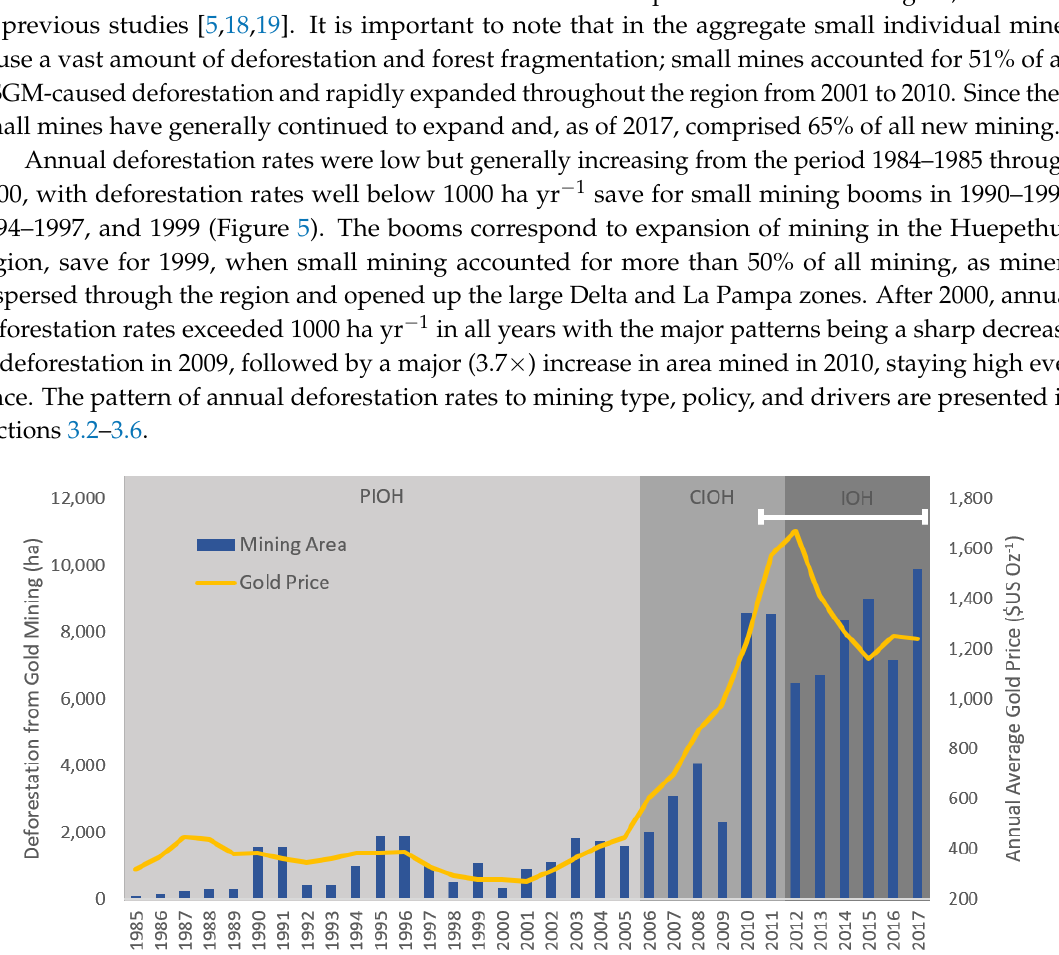
Figure 5. Annual rate of deforestation over 34 years due to ASGM in the Southeastern Peruvian Amazon. Particularly notable is the sharp increase in mining in 2010, which correlates well with gold price, followed by consistently high levels of mining in the years since, even while gold prices fluctuate. Shading refers to stage of infrastructure construction: Pre-Interoceanic Highway (PIOH), Construction phase of the interoceanic highway (CIOH), and operational phase (IOH). The white horizontal line from 2011 through the present indicates the phase of interdictions against illegal mining by the Peruvian National Police and military.